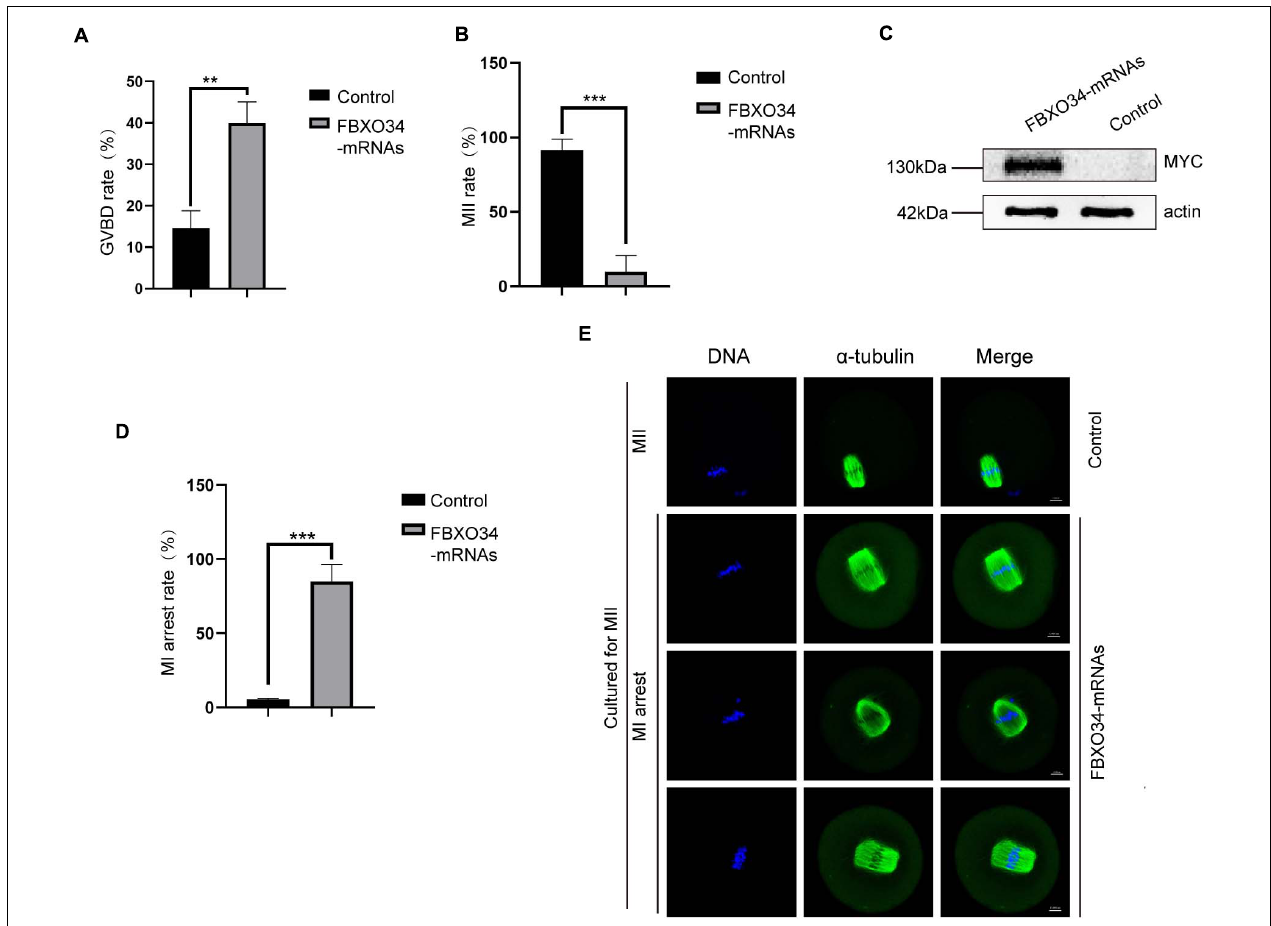
FIGURE 4 | Effects of FBXO34 overexpression on resumption and progression of meiosis. (A) GVBD rates at 3 h after being released to M2 medium with 50 µ M IBMX for control and FBXO34-overexpressed oocytes. (B) MII rates of control and FBXO34-overexpressed oocytes. (C) Western blot of FBXO34-MYC and actin in control, FBXO34 mRNA–injected oocytes (100 oocytes per sample). The molecular weight of FBXO34-MYC is 130 kDa, and the molecular weight of actin is 42 kDa. (D) The rates of MI arrest oocyte in control and FBXO34-overexpression groups. (E) Oocytes in the control and FBXO34-overexpression groups were cultured for 12 h followed with staining with α -tubulin (green) and DNA (blue). Scale bar, 10 µ m. Quantitative data were obtained from at least three independent repeats, and one repeat of each experiment contained at least 50 oocytes. The error bars of quantitative data represent the standard deviation (** P < 0.01, *** P <